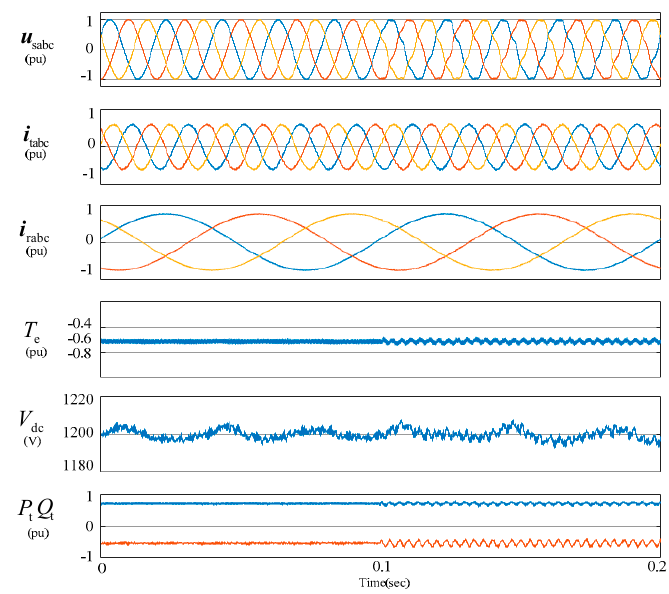
Figure 9. Simulation results of the MRSMC for a DFIG system.